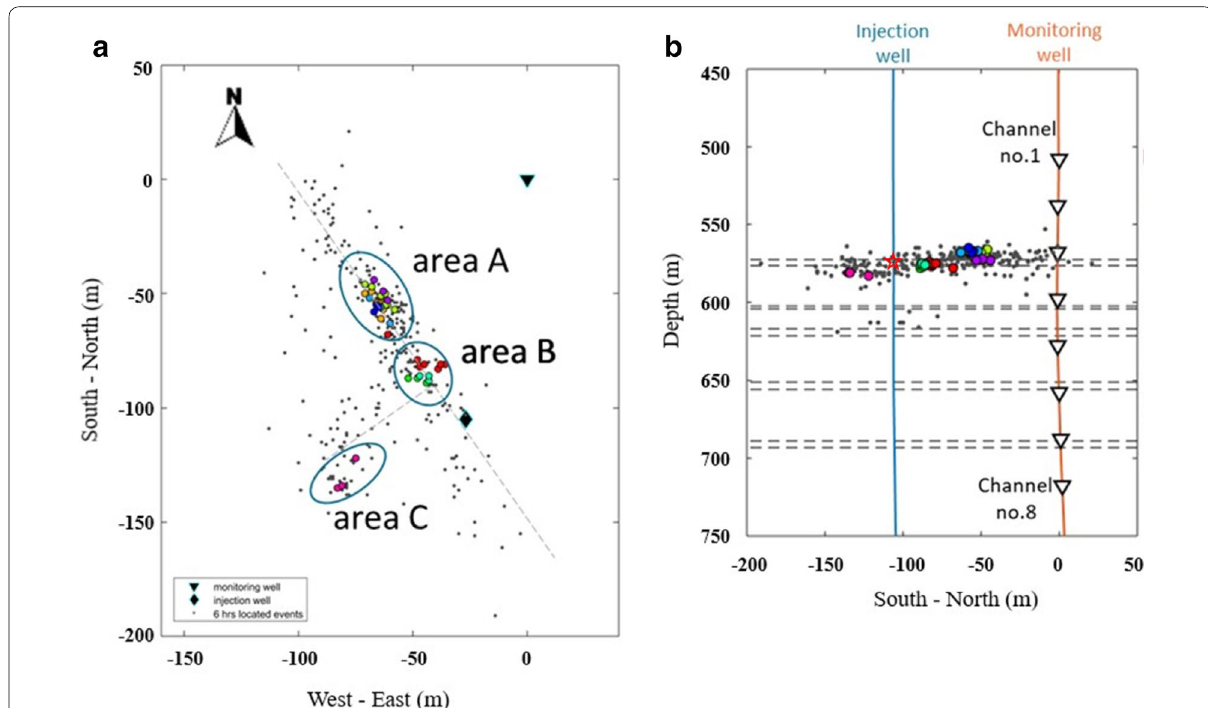
Fig. 5 Identified multiplet groups in a map view suggesting two orientations for hydraulic fracturing: primarily N330° and secondarily N240° ( a ). A vertical section in South–North projection showing the triggered microseismic events is mostly located in the coal zone of injection indicated by red star ( b ). Horizontal dash lines are coal thickness at the injection well